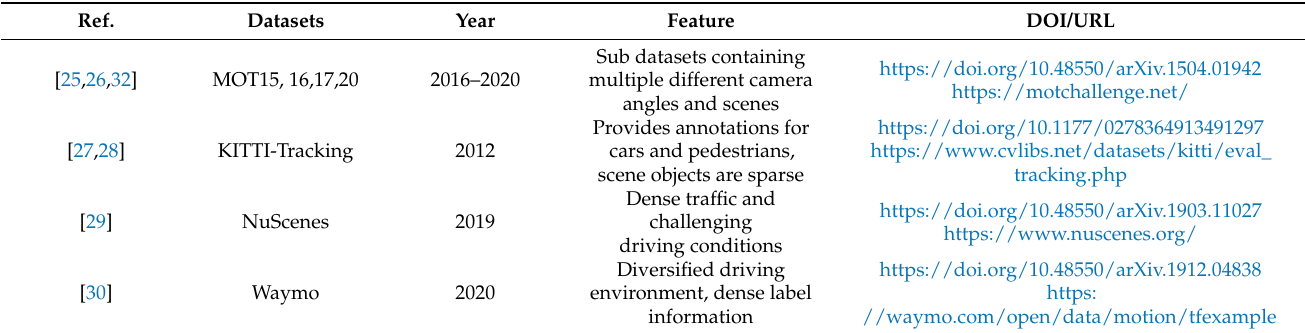
Table 3. Summary of Visual Multi-object Tracking